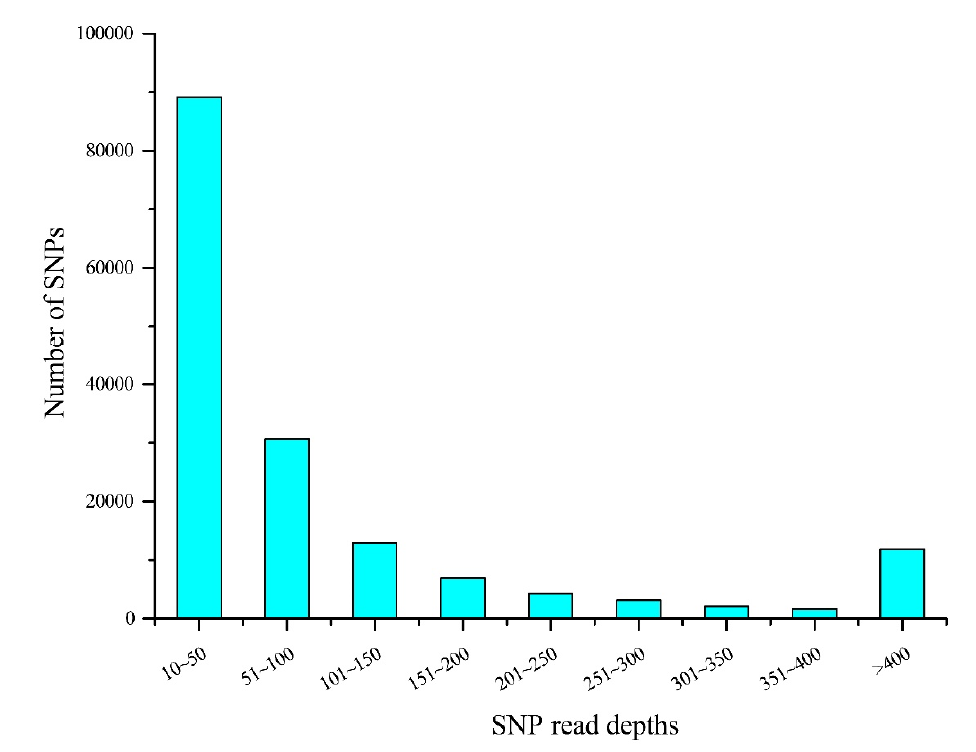
Figure 2. Statistics for 162,571 presumptive SNP read depths.